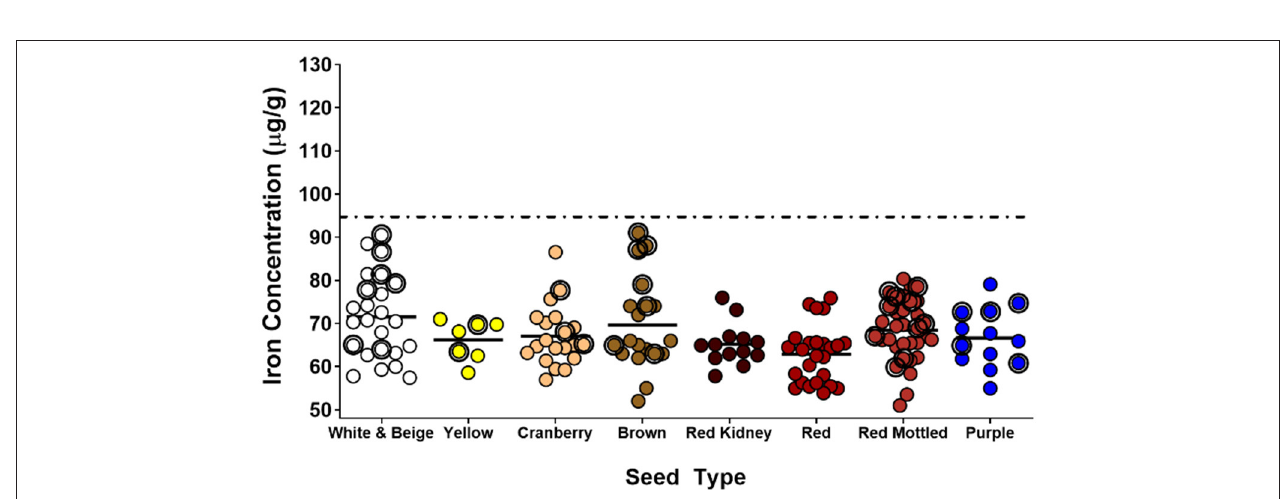
FIGURE 1 | Iron concentrations of seed collected from marketplaces throughout countries of East Africa. Points with green circles indicate lines released as “biofortified.” Dashed line indicates the target value for biofortified beans. Adapted from Glahn et al. (2020).